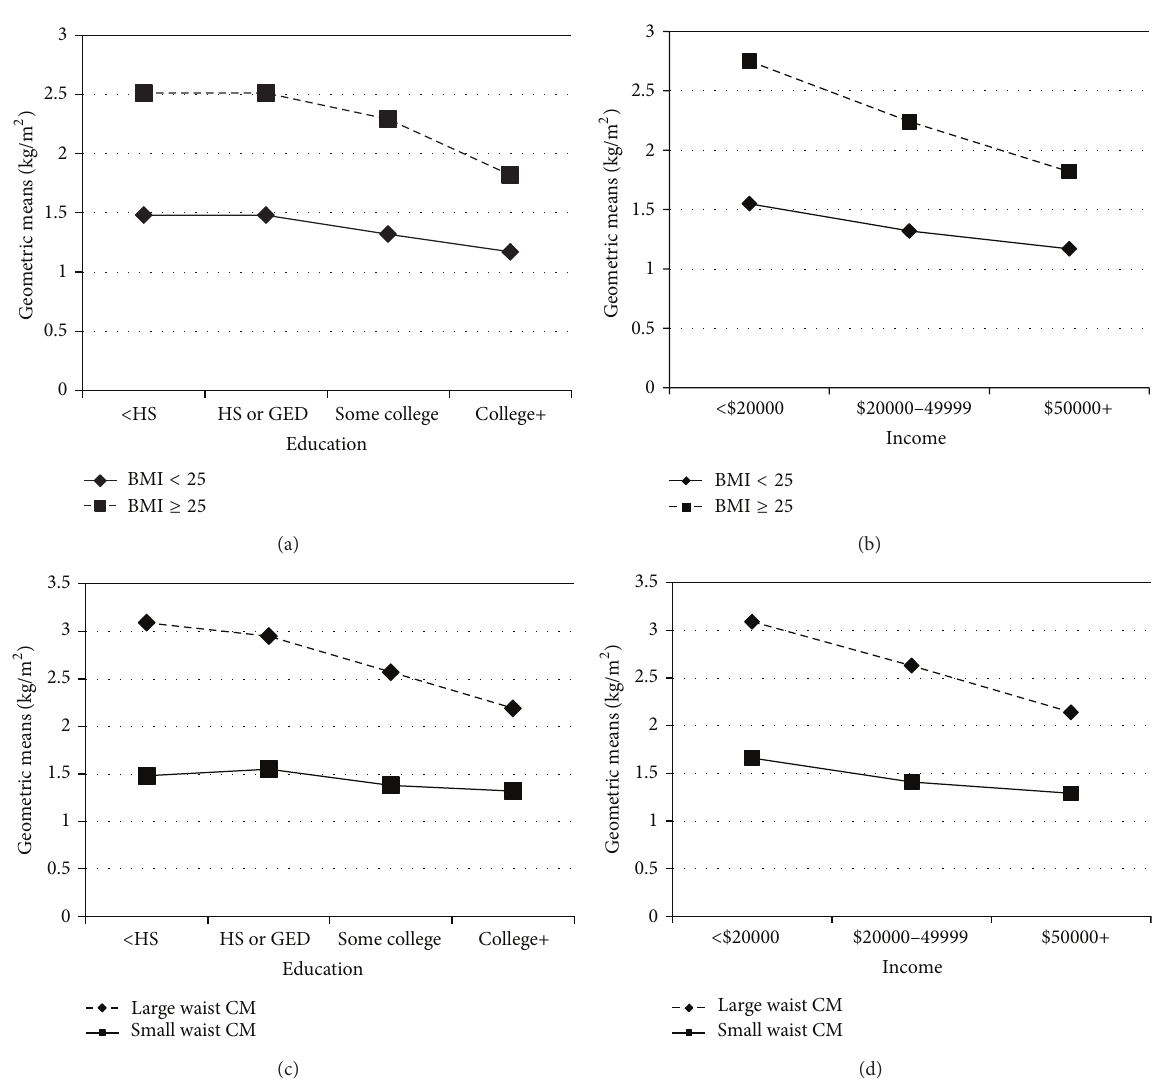
with large waist cm compared to small waist cm within all levels of education and income ( 𝑃 ≤ 0.0001 in all